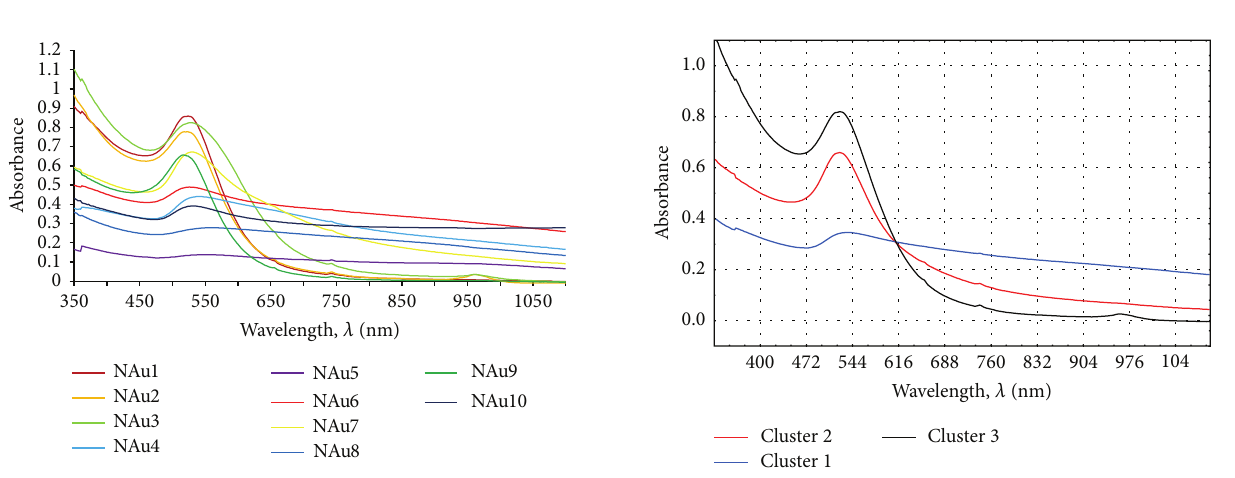
Figure 12: Chart of average clusters containing NAu suspension